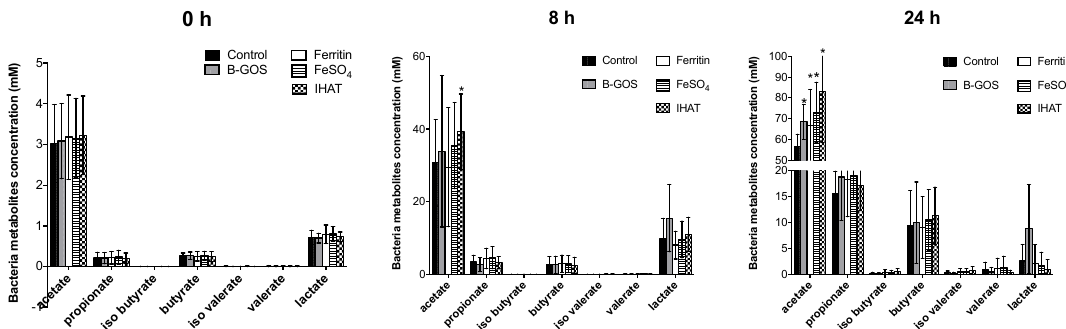
Figure 7. SCFA production at baseline (0 h), 8 and 24 h of fermentation in pH-controlled batch cultures inoculated with faeces from diarrhoea-predominant IBS (IBS-D) donors. Values are mean ± SD of five independent experiments (five IBS-D donors). *, significant differences from the control condition (i.e., gut model media only, with no additional test substrate), p < 0.05.